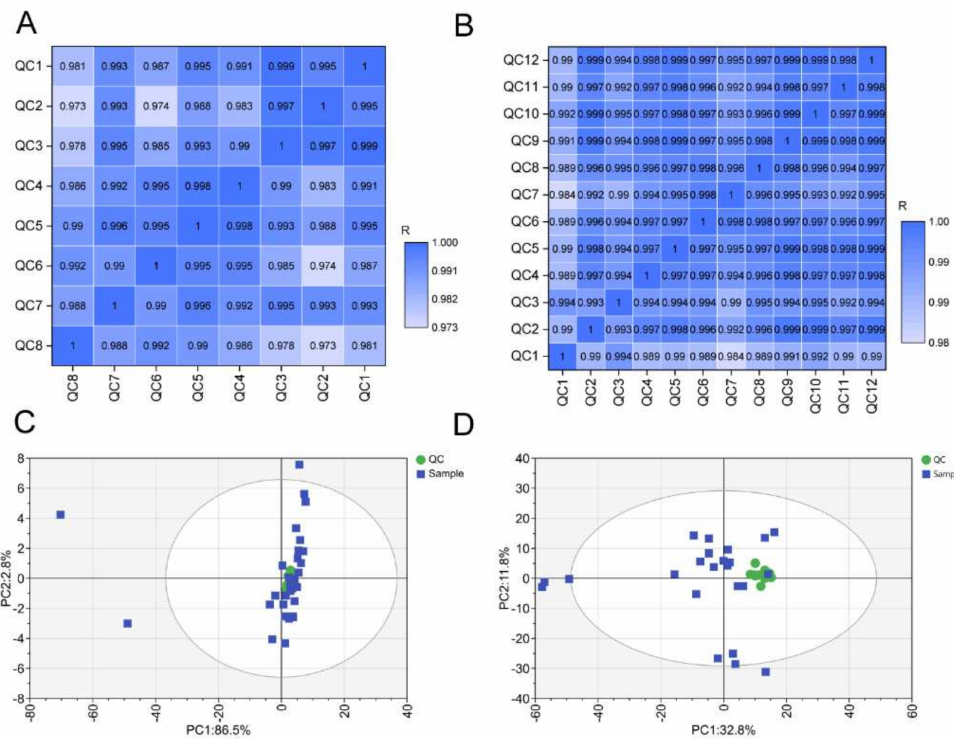
Figure 1. Quality control assessment. The Pearson correlation of serum ( A ) and hippocampus tissues ( B ) in ESI − mode. The PCA score plots for all serum ( C ) and hippocampus ( D ) samples containing QC samples in ESI − mode. ESI − : negative electrospray